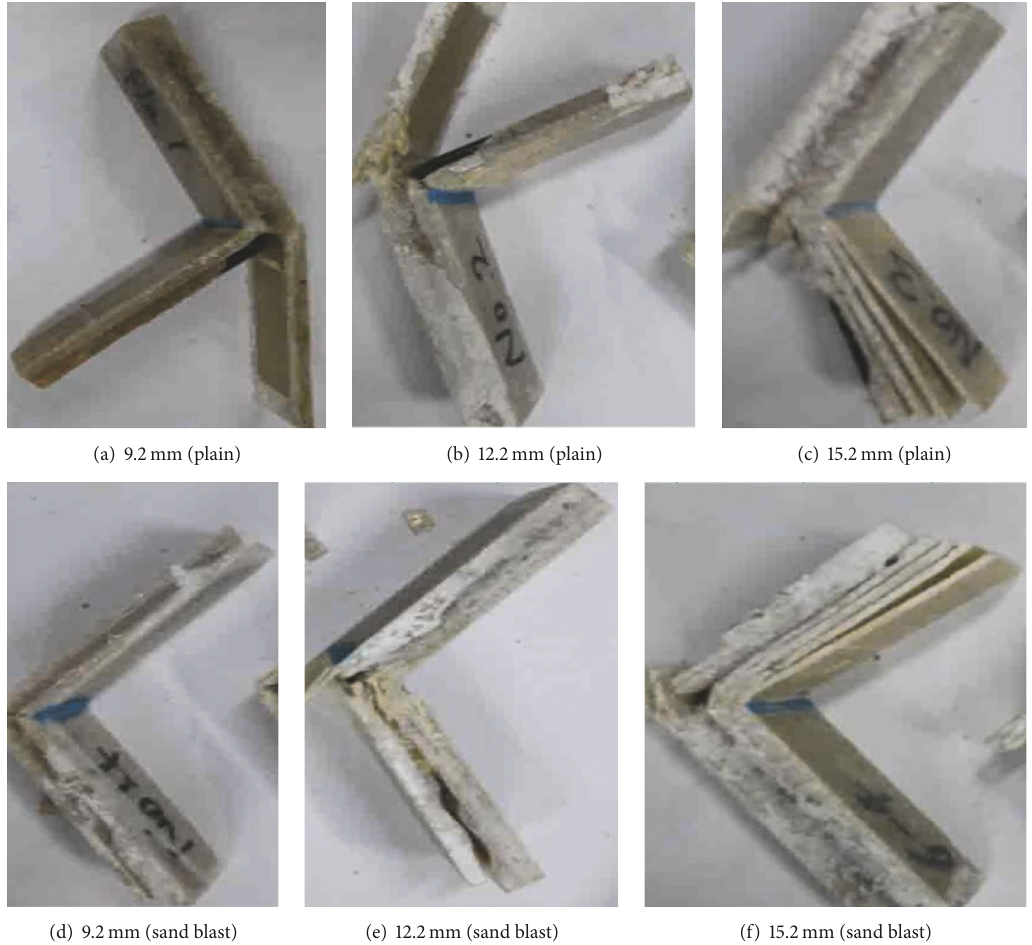
Figure 16: Fracture deformation with thickness of hybrid panels after Na 2 SO 4 solution